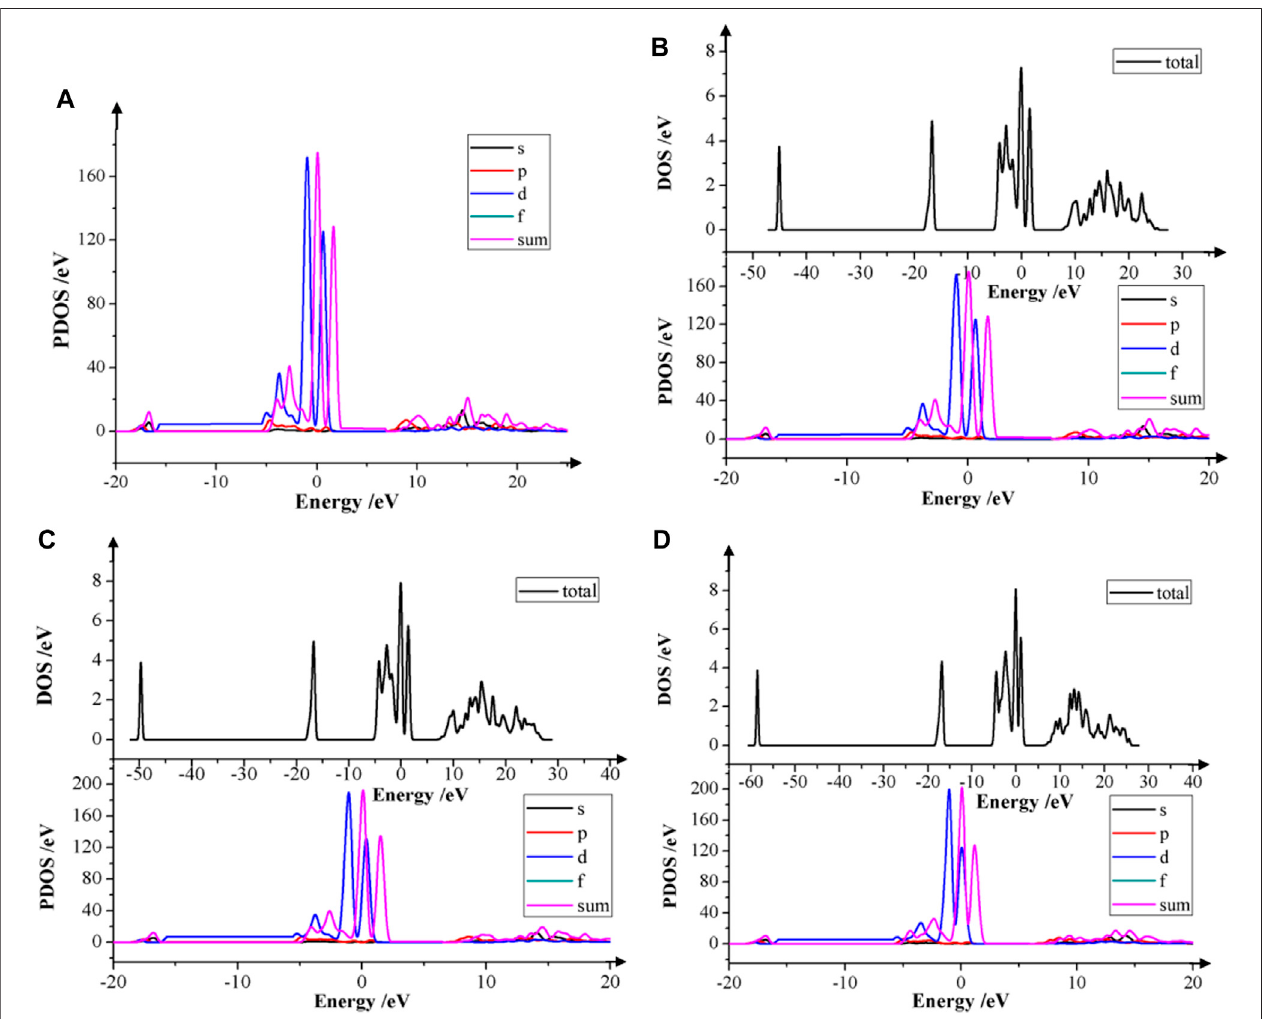
FIGURE 3 | PDOS schemas of Li 1.2 − x Na x Mn 0.54 Ni 0.13 Co 0.13 O 2 with different x . (A) When x (cid:2) 0 mol, the PDOS peak of the pristine is about 173 eV. (B) The PDOS peakofLi 1.19 Na 0.01 Mn 0.54 Ni 0.13 Co 0.13 O 2 isupto181 eV,whichishigherthanthatofLi 1.2 Mn 0.54 Ni 0.13 Co 0.13 O 2 . (C) When x (cid:2) 0.04 mol,thePDOSpeakraisesaroundto 201 eV. The bigger Li – O layers contribute to the better conductivity. (D) When x (cid:2) 0.10 mol, the PDOS peak is approximately 207 eV, which is higher much than that of Li 1.2 Mn 0.54 Ni 0.13 Co 0.13 O 2